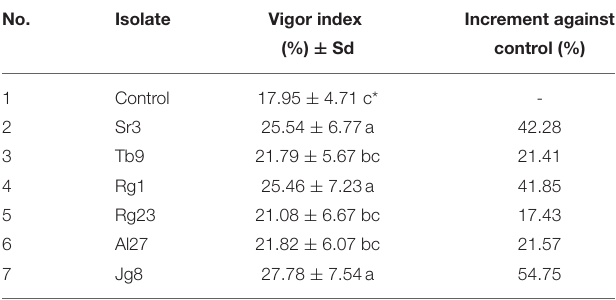
TABLE 3 | Effect of rhizobacteria to the vigor index of corn cultivar Pertiwi at the age of 7 days. No.